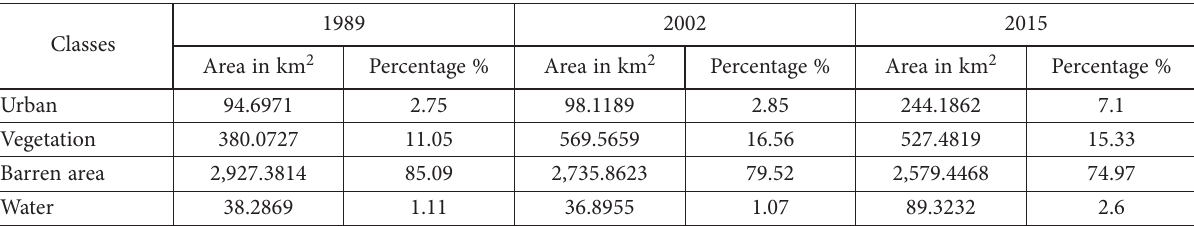
Figure 6. The percentages of LULC classes in three Table 4. LULC statistics of the Tikrit City; in 1989, 2002, in 2015